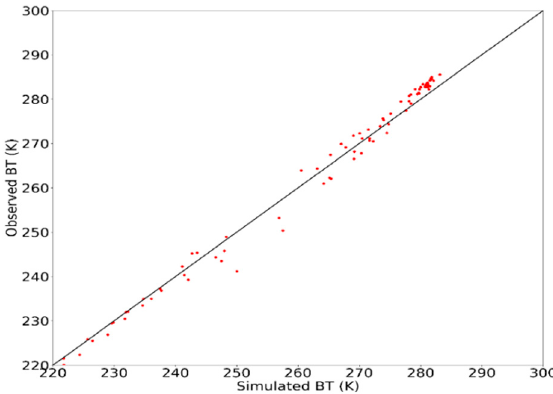
Figure 3. Scatterplot of the observed BT against the simulated BT.